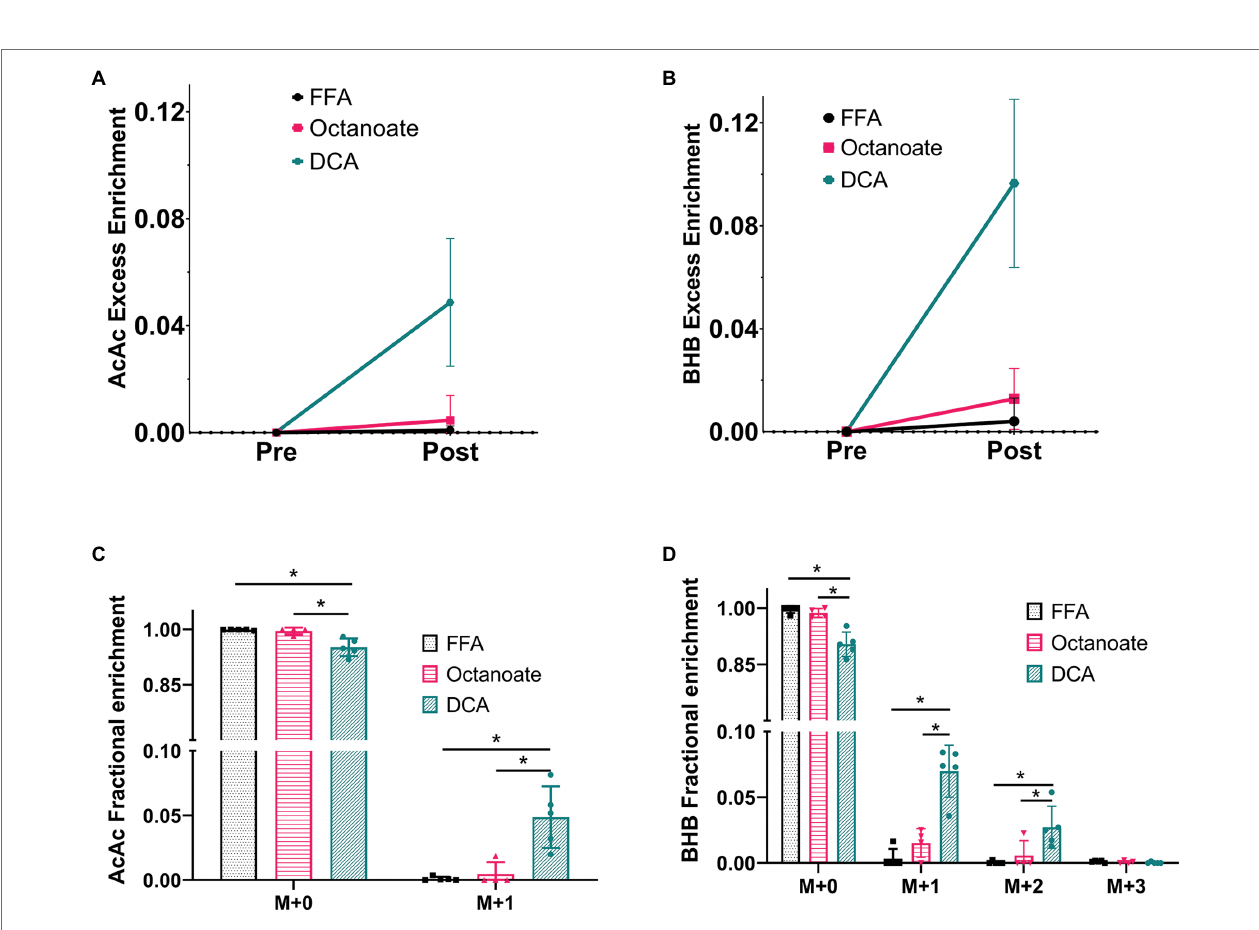
FIGURE 3 | Fractional enrichments for the ketones Acetoacetate and 3-hydroxybutyrate based on GC-MS analysis of efferent perfusate. The data shown is presented after natural abundance correction using the INCA software, which results in no excess enrichment prior to the injection. (A,B) Enrichments for ketones produced prior to [2- 13 C] pyruvate were confirmed to contain no label while ketone enrichment was observed to increase in the octanoate and DCA groups considerably indicating labeled ketone production from [2- 13 C] pyruvate. (C,D) The fractional enrichment profile for Acetoacetate (M + 0–1) and BHB (M + 0–3) showed significantly higher label in the DCA group than the FFA and octanoate groups for all but BHB M + 3. BHB M + 3 cannot be produced from [2- 13 C] pyruvate and hence has an enrichment within the error of measurement ~0.1% or 0.001. * Indicates statistical significance ( p < 0.05; see section Materials and